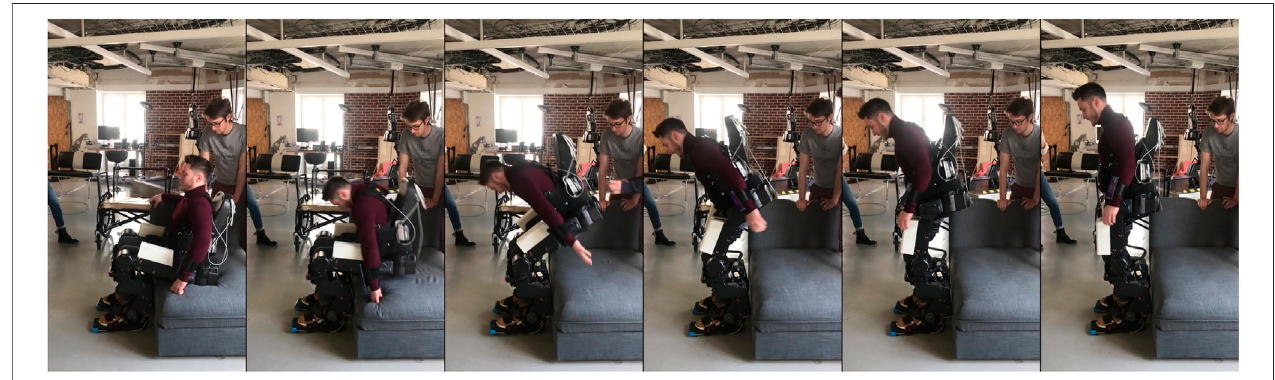
FIGURE 11 | Pilot standing-up from the